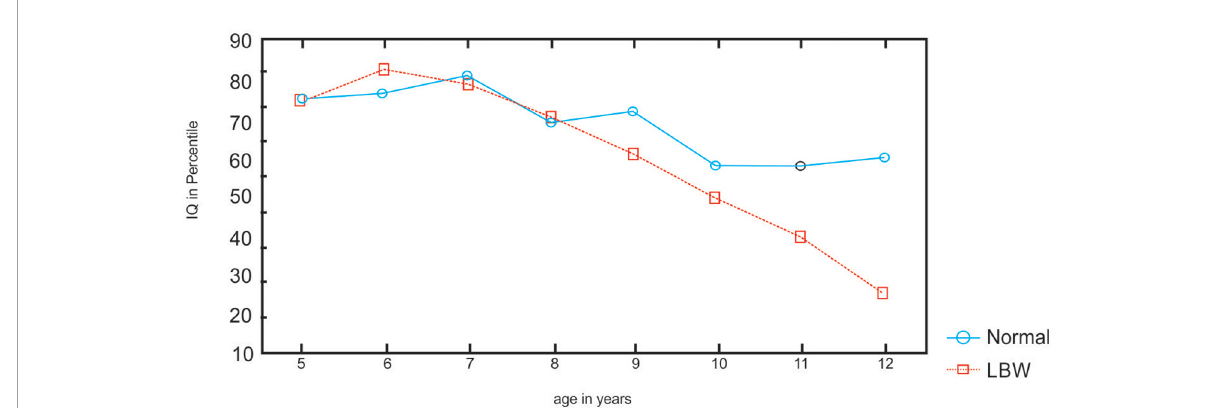
FIGURE1 Percentile scores of the LBW and NBW children on Ravens test.